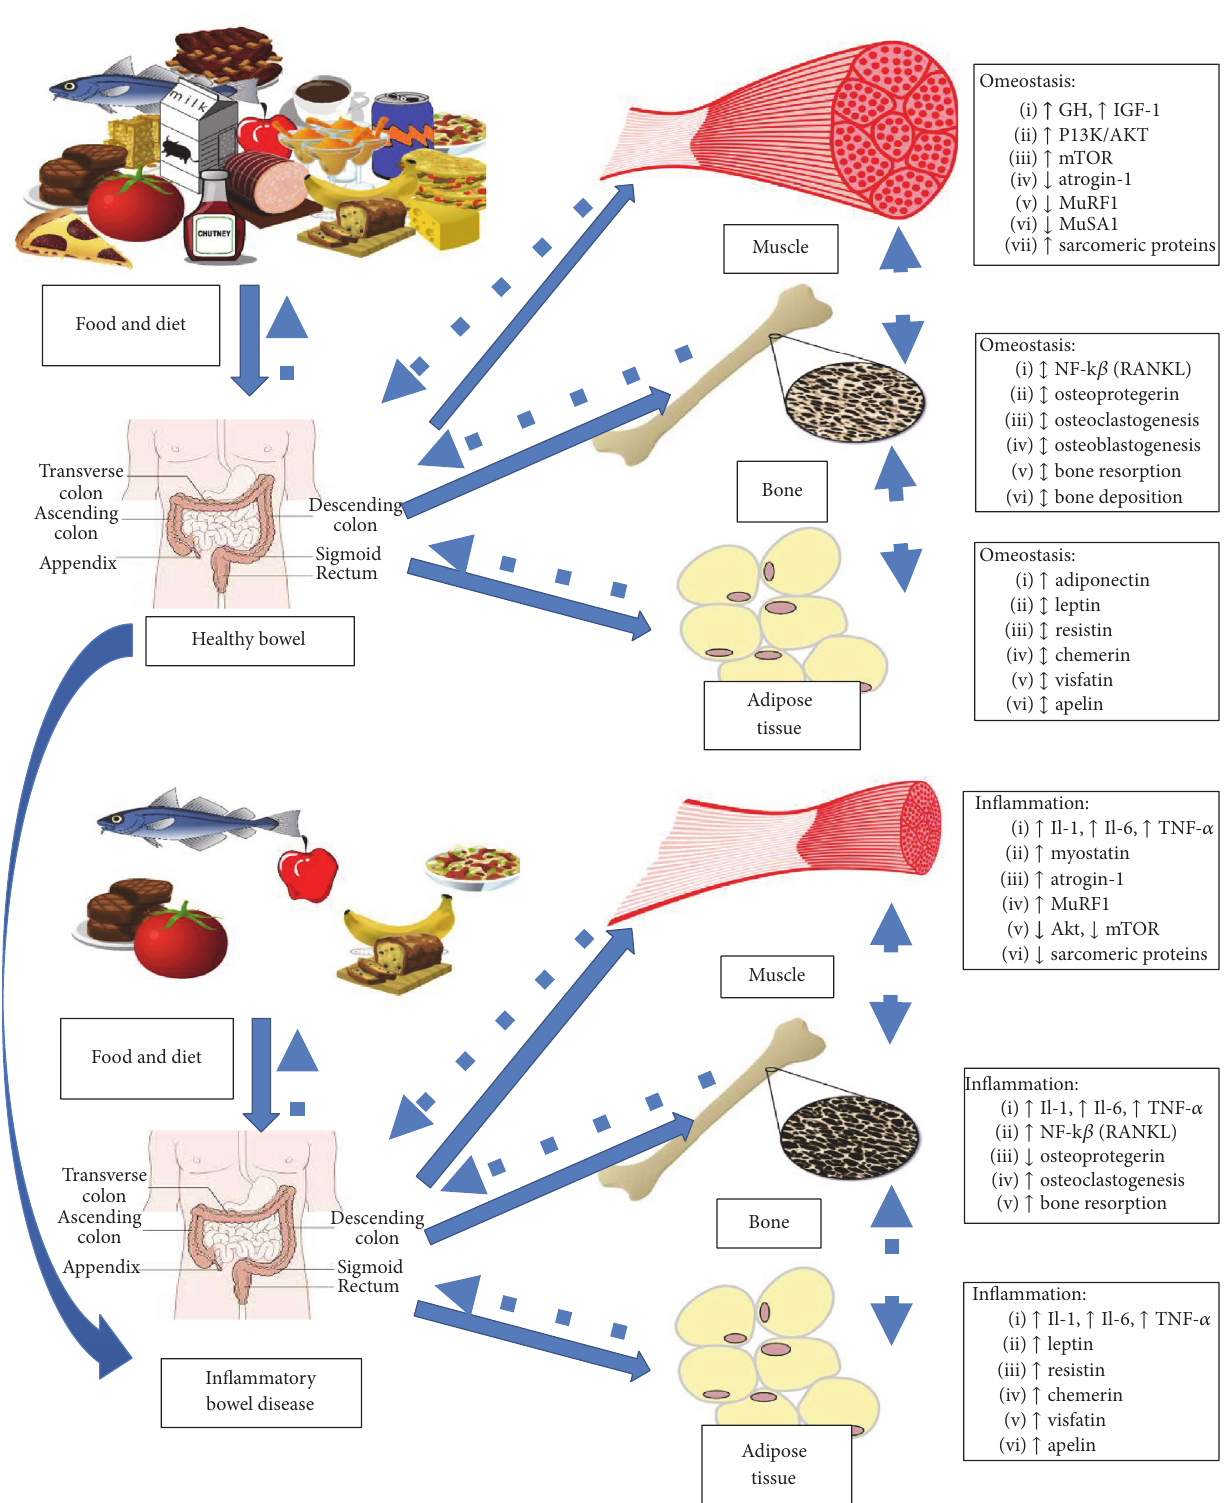
Figure2:Pathophysiologyofmalnutritionandsarcopeniaininflammatoryboweldisease.Interplaybetweennutrition,inflammation,muscle, bone, and adipose tissue in healthy subject and